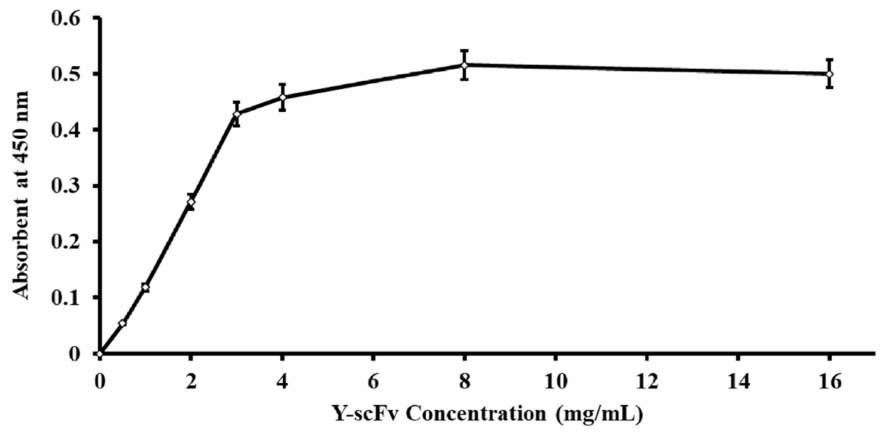
Figure 3. Correlative amount of Y-scFv antibody coupled to the surface of PLA-M magnetic beads.